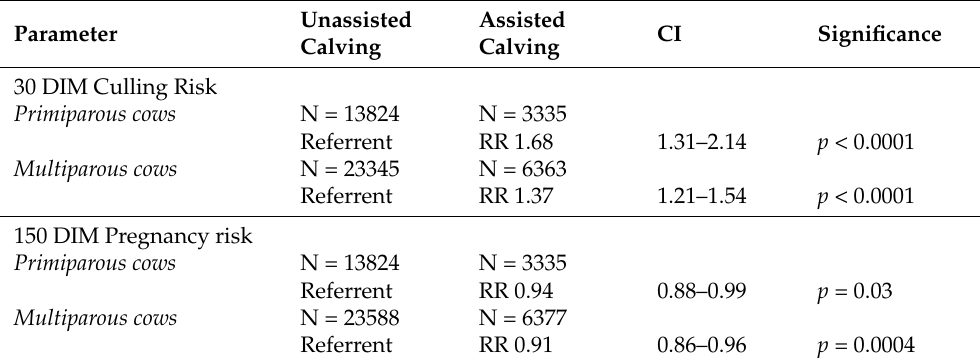
Table 4. Risk ratios and 95% confidence interval for the associations between calving ease and survival and between calving ease and